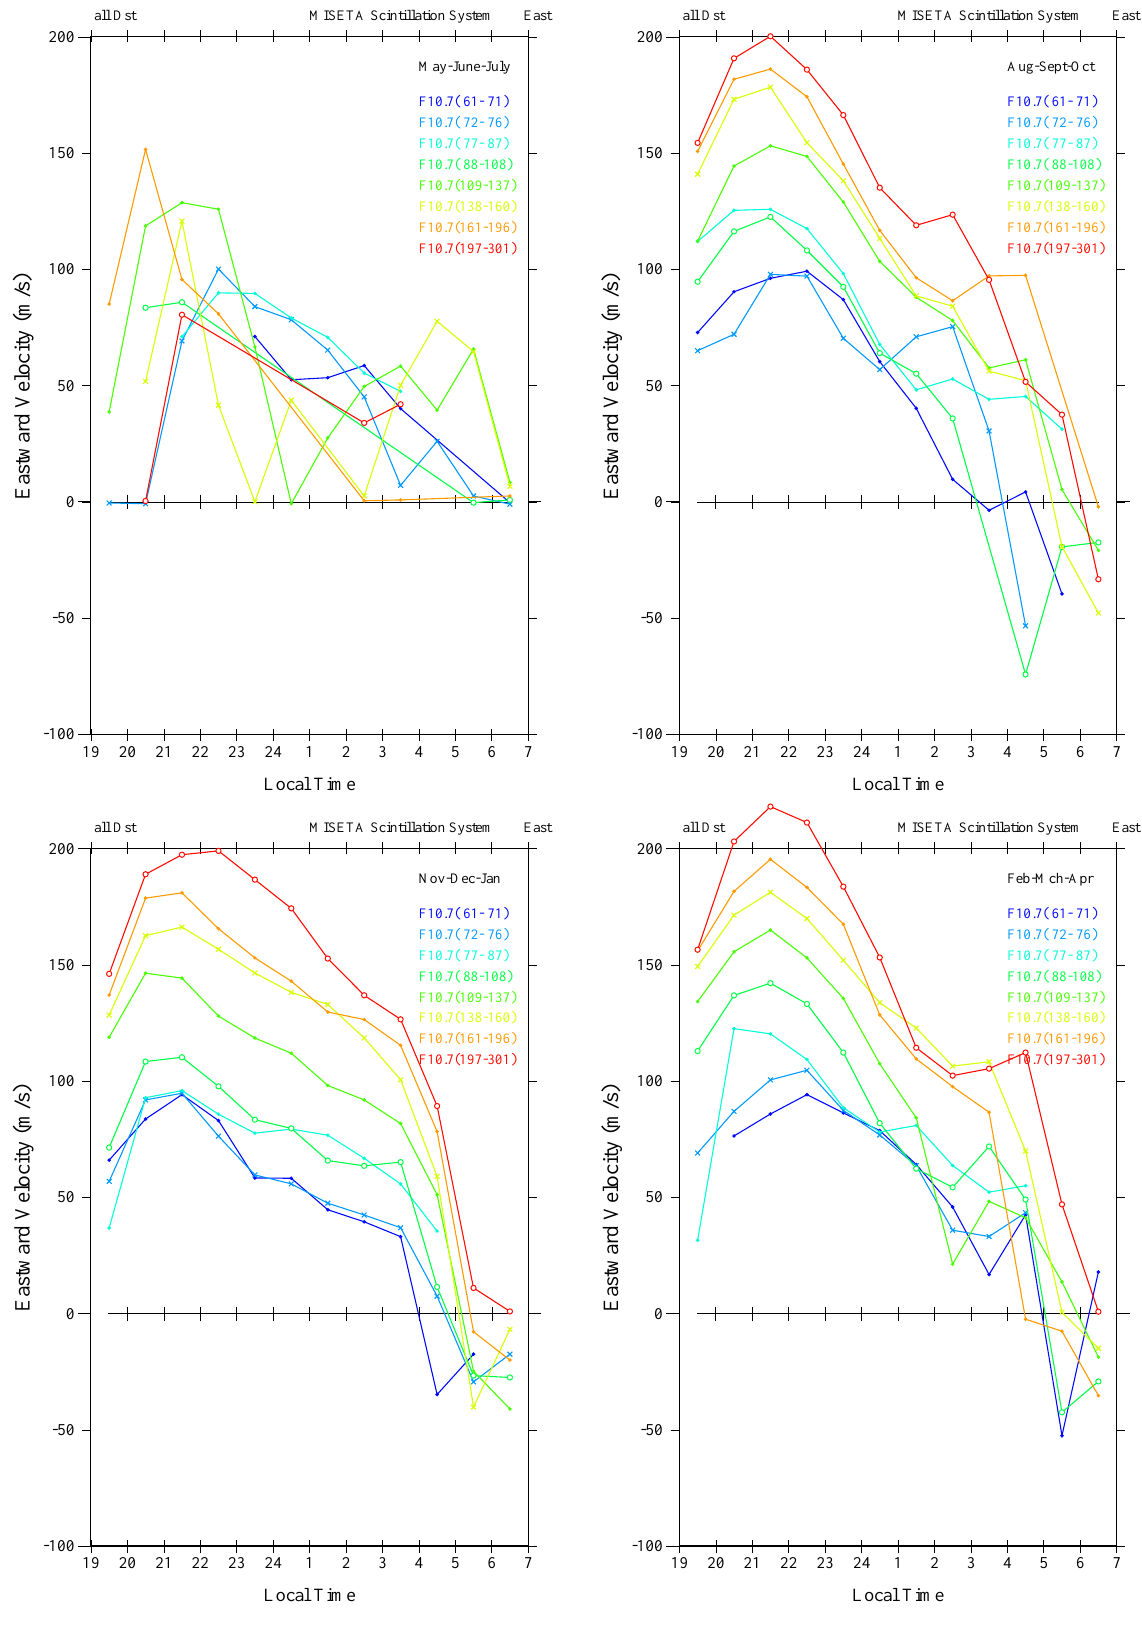
Fig. 3. Seasonal average zonal drifts for